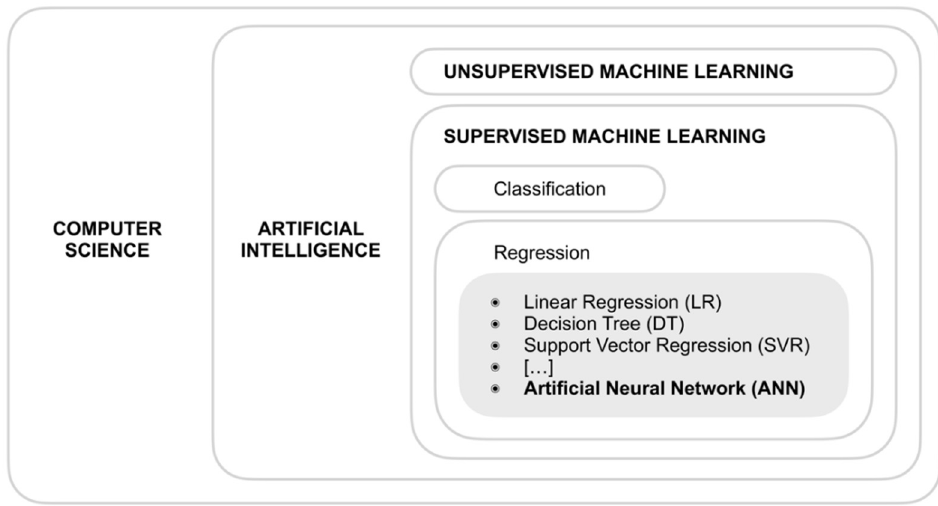
Figure 2. Computer science subcategories.